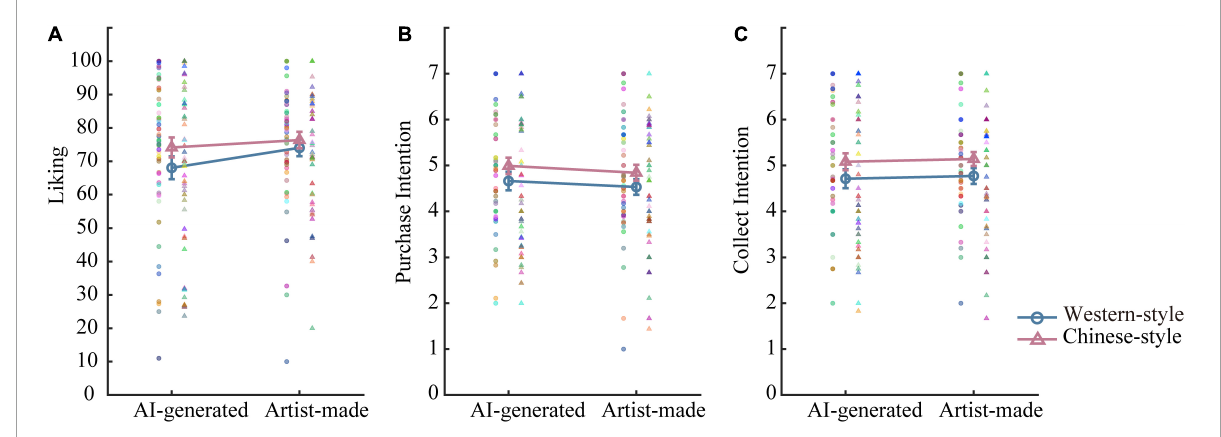
FIGURE1 Mean values for the four conditions (author: AI vs. human artists; style: Western vs. Chinese style) in study 1. Participants gave higher ratings for Chinese-style paintings (A) and showed higher purchase intention (B) and collection intention (C) for Chinese-style paintings. Error bars stand for ±